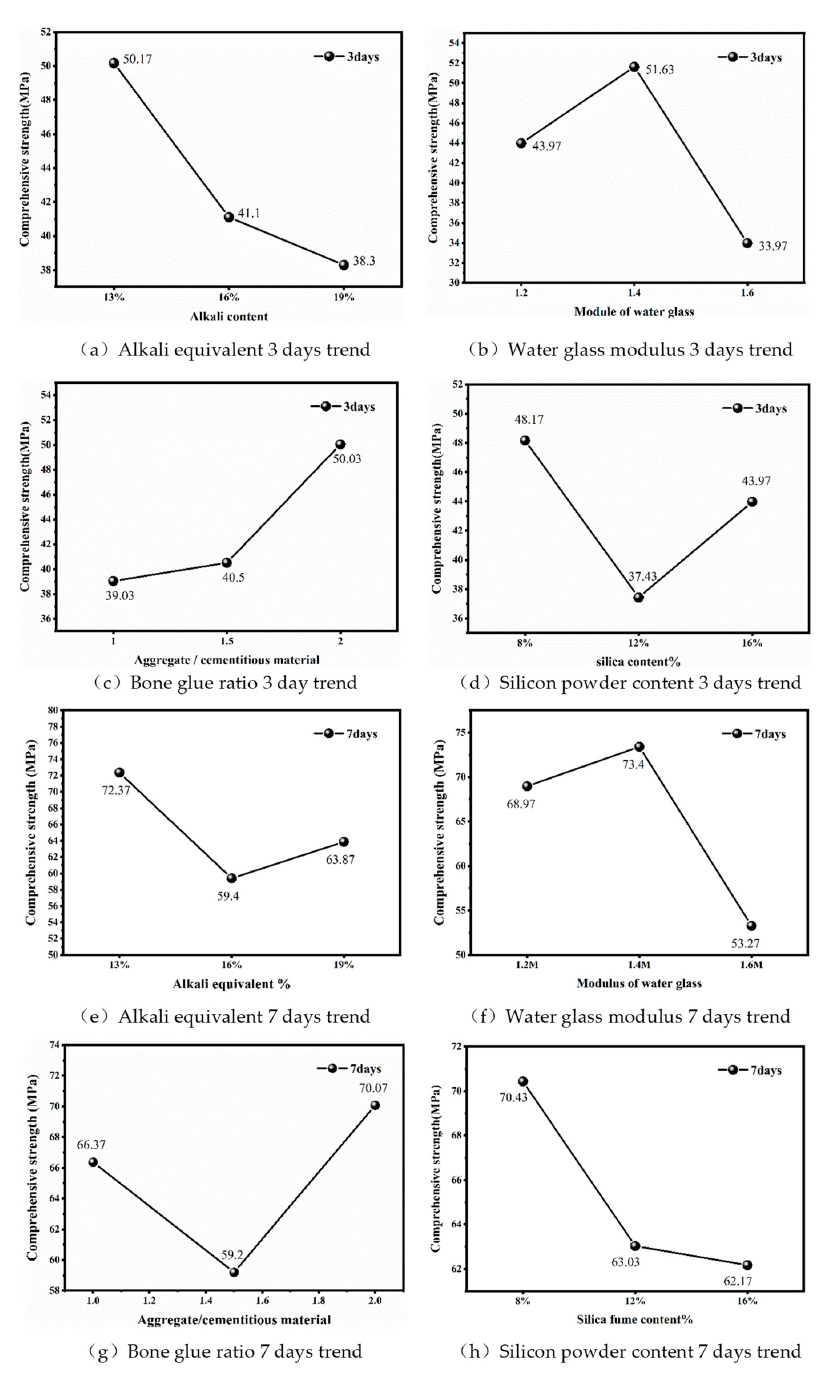
Figure 6. Influence mortar 3 days, 7 days level change trend. Compressive strength: Figure 7 shows the 3 ‐ day and 7 ‐ day compressive strength values of polyether defoamer and silicone defoamer with different dosages. The 3 ‐ day and 7 ‐ day compressive strength of MKSF ‐ 0% is higher than that of the sample after adding defoamer the compressive strength value, and the defoamer changes the cohesive force of the inorganic macromolecular polymer produced by the geopolymer reaction, thereby reducing the overall strength of the mortar, which is reflected in the subsequent fluidity test, microscopic test, and further discussions. In addition, it can be seen from Table 8 that